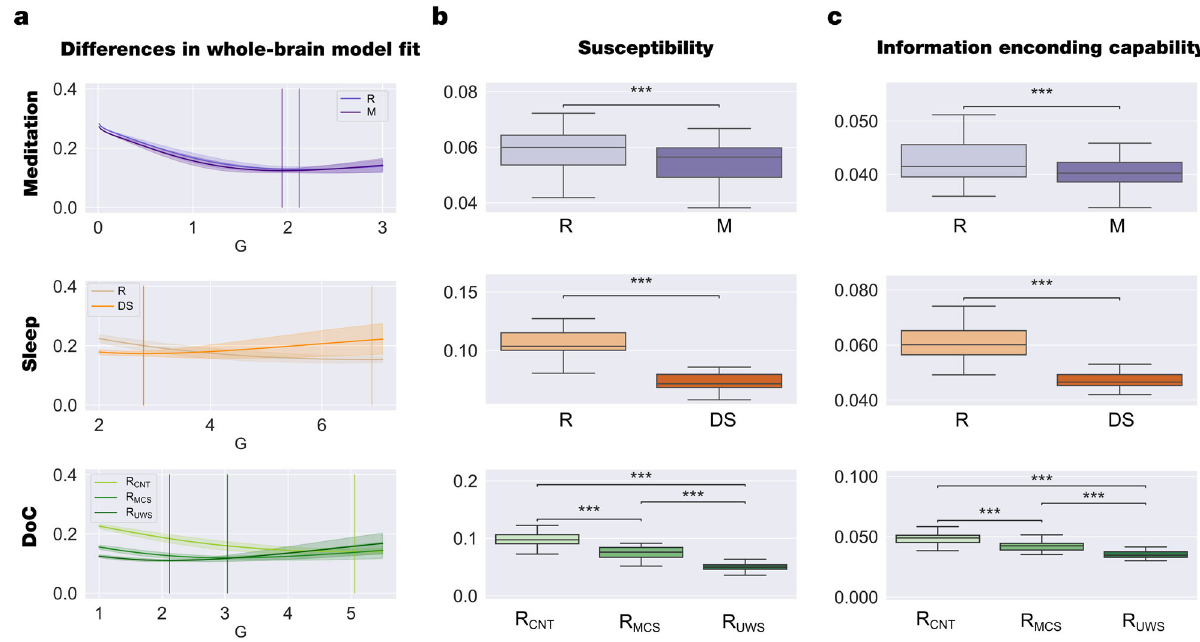
Fig. 5 Model-based framework revealed signi fi cant perturbative differences for different brain states. a We show the evolution of the error of the whole-brain model FC fi tting to the empirical fMRI data as a function of the global coupling strength, G. The error of the FC fi tting was given by the square root of the difference between the simulated and empirical FC matrix. The optimal working point of the model was de fi ned as the minimum value of the FC fi tting, i.e., where the model shows maximal similarity to the empirical fMRI data. b We show the results of the susceptibility measure, which estimates how these models react to external periodical force perturbations. In all datasets, the resting state was the most susceptible to be perturbed. c We show the information encoding capability of the whole-brain models, which captures how different external stimulations are encoded in the dynamics. Similar to the susceptibility measure, the resting state was more susceptible to react to the perturbations. Susceptibility and information capability measures differentiated each brain state and between R MCS and R UWS groups. These results show that each brain state encodes the whole-brain dynamics with a particular complexity. P -values were assessed using the Wilcoxon rank-sum test and corrected for multiple comparisons; *** P <